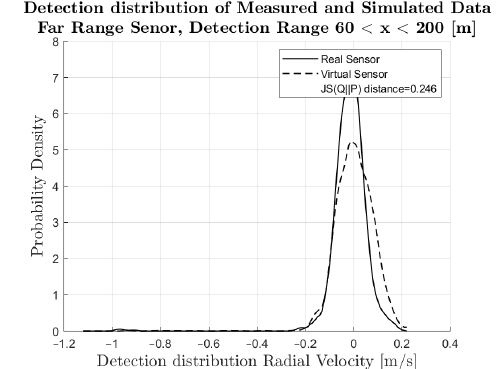
Figure A3. Evaluation of the detections in the range of 60 to 200 m of the far-range radar sensor and sensor model: PDF of the relative velocity in the x -direction from the reference velocity of the real sensor and sensor